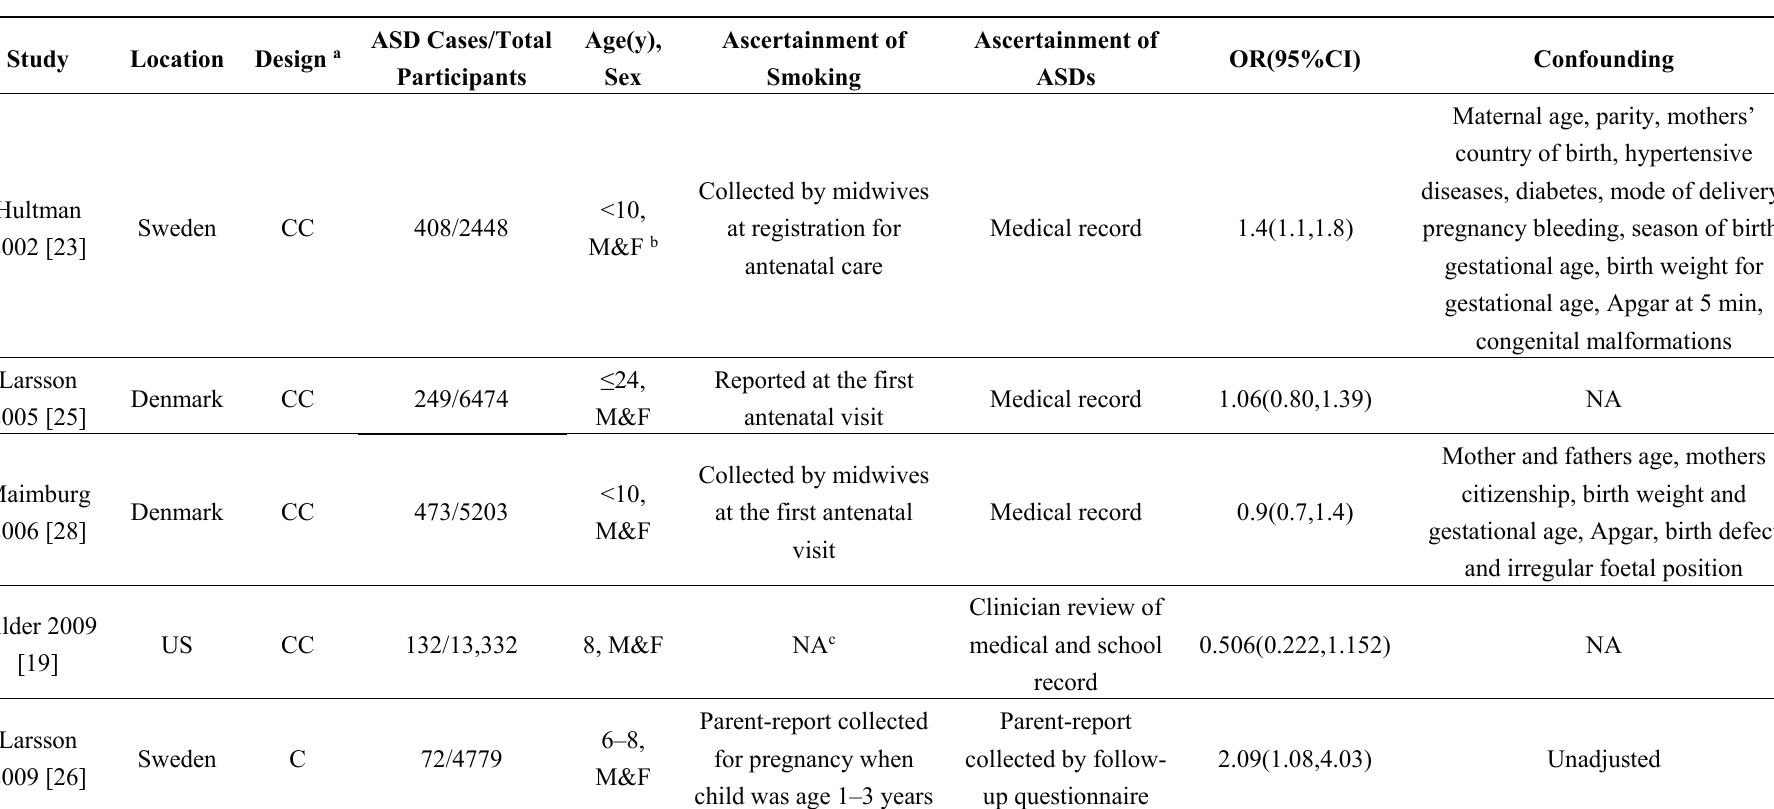
Table 1. Characteristics of included studies of maternal smoking during pregnancy and ASD risk in the